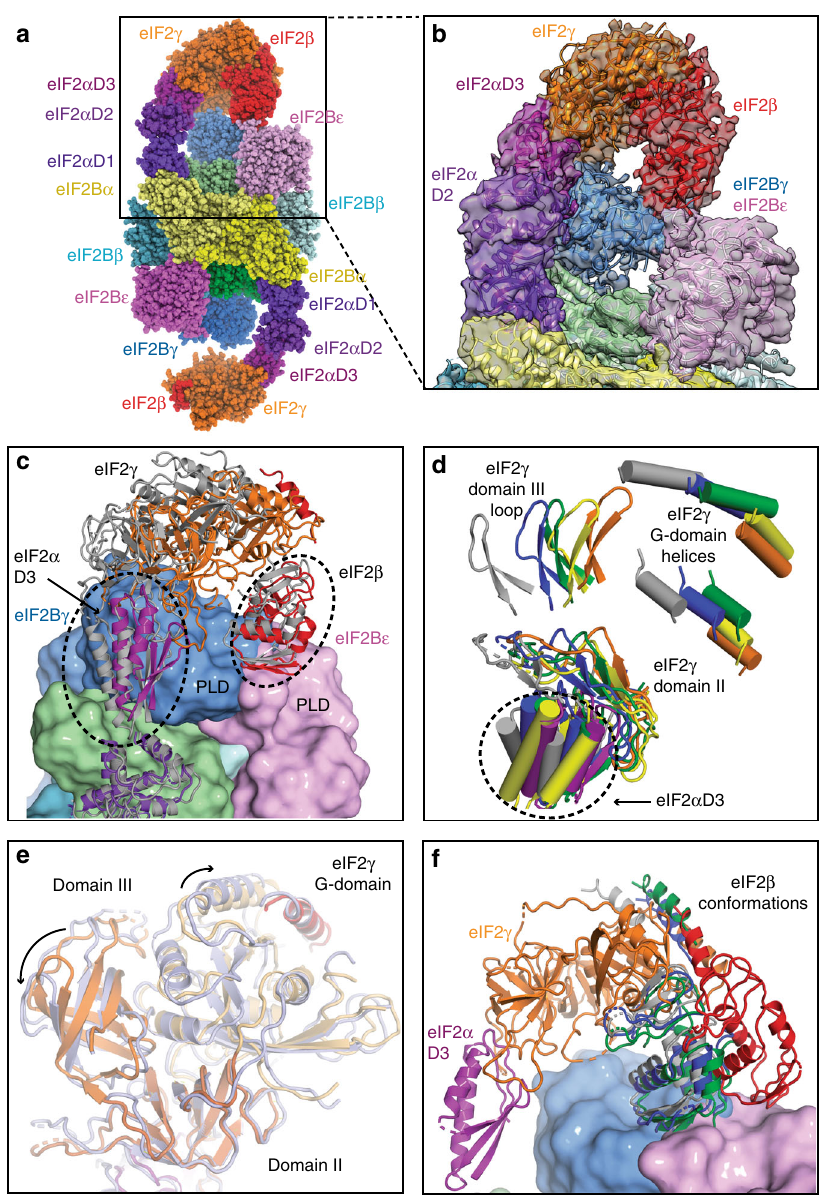
Fig. 3 Contacts of eIF2 β and γ with the catalytic subunits of eIF2B. a eIF2B – eIF2( α P) complex model in spheres representation fi tted in map A showing tilted conformation of eIF2 γ , which is stabilised by its contact with eIF2B γ and extended conformation of eIF2 β contacting the interface area of the two γ and ε catalytic subunits of eIF2B. b Close-up view of the model fi tting into the density of map A. c Modelled positions of eIF2 γ and β subunits after classi fi cation, showing extensive movements of these subunits around eIF2B ε and γ PLD domains. For clarity, only two eIF2 models are shown (corresponding to maps A — coloured and C — grey). d Modelled positions of eIF2 γ subunit and eIF2 α -D3 in all three maps (map 1 — orange for eIF2 γ and purple for eIF2 α -D3, map A — blue, map B — green, map C — grey, map D — yellow). For clarity, only few elements in each of the eIF2 γ domains are shown. e Superposition of domain II of eIF2 γ in map A (coloured light blue) with that in map 1 (eIF2 γ coloured orange) shows the rearrangement of three eIF2 γ domains when it is in the tilted conformation. f Conformation of eIF2 β fi tted in map D (red) is different from the conformations found in three other maps (A - blue, B - green and C - grey). eIF2 γ and α shown are from map